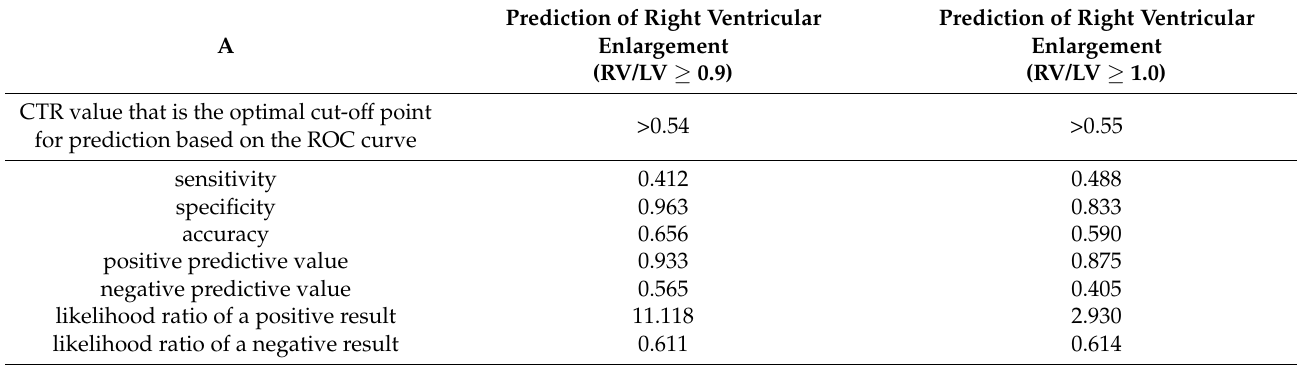
Table 6. Sensitivity, specificity, and accuracy of the radiographic cardiothoracic ratio as a predictor of right ventricular enlargement in pulmonary CTA. (A) In the whole group. (B) In subgroups divided according to the age criterion. (C) In subgroups divided according to the BMI criterion. (D) in subgroups divided according to the gender criterion. (E) in subgroups divided according to the pulmonary embolism criterion.